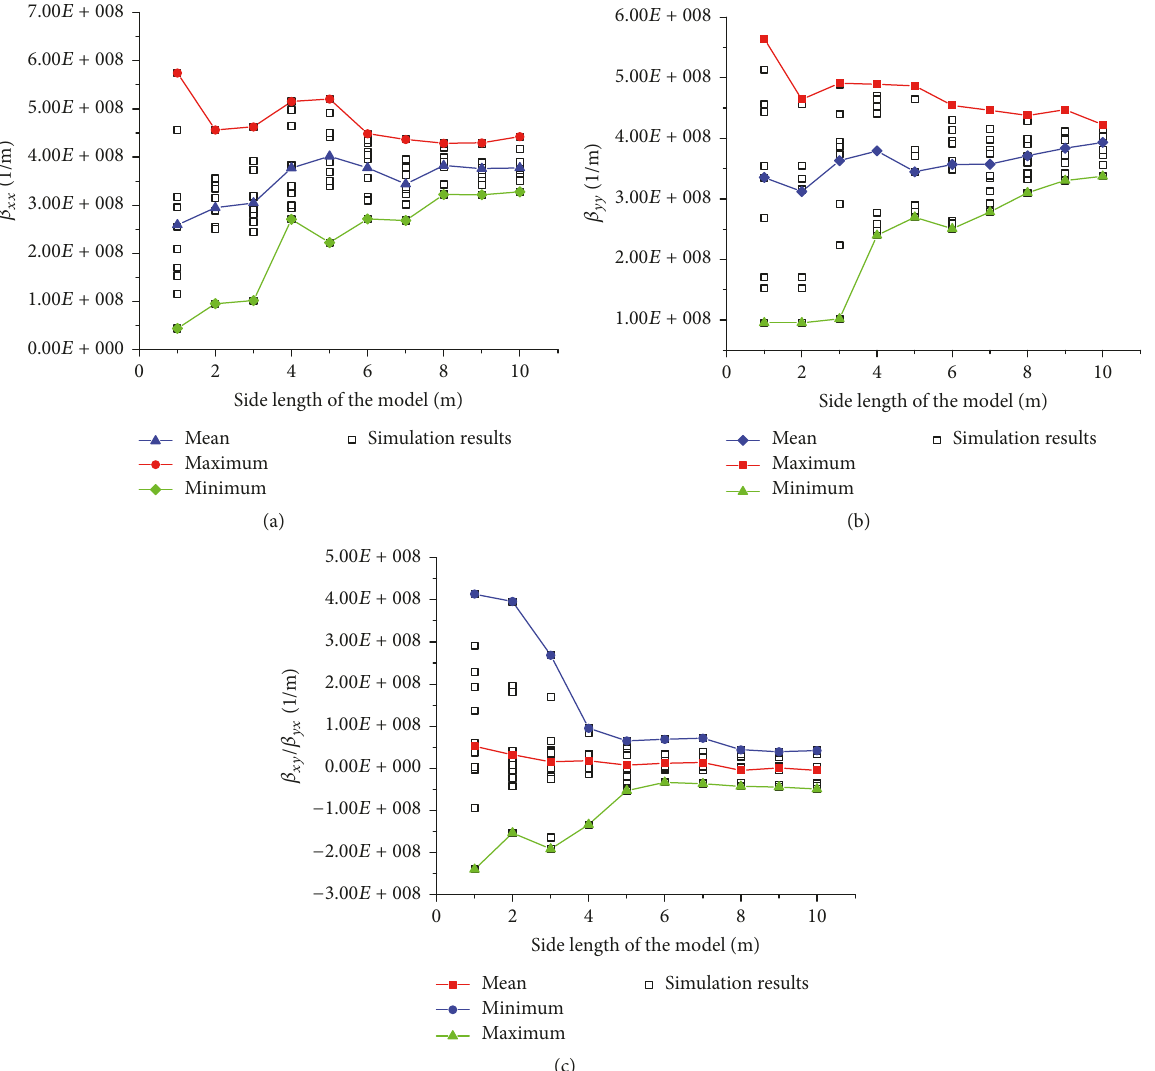
Figure 24: The results, Max, Min, and mean of calculated non-Darcy coefficient components in the non-Darcy flow. (a) 𝛽 𝑥𝑥 , (b) 𝛽 𝑦𝑦 , (c) 𝛽 𝛽 𝑥𝑦 , and 𝑦𝑥 .